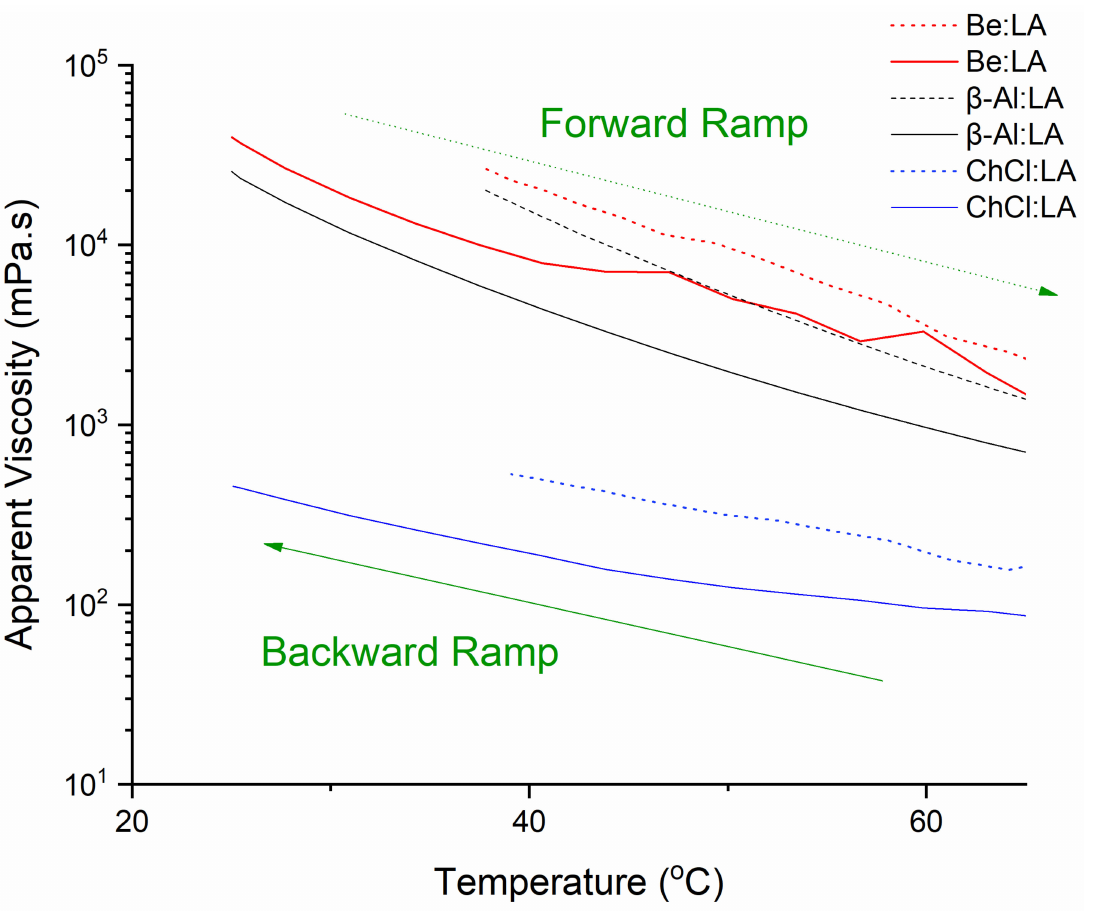
Figure 2. Effect of heating and cooling rate on the apparent viscosity at a low shear rate of 1 s − 1 . Curves are generated using 26 data points, temp ramp rate of 3 ◦ C, and time ramp of 1.6